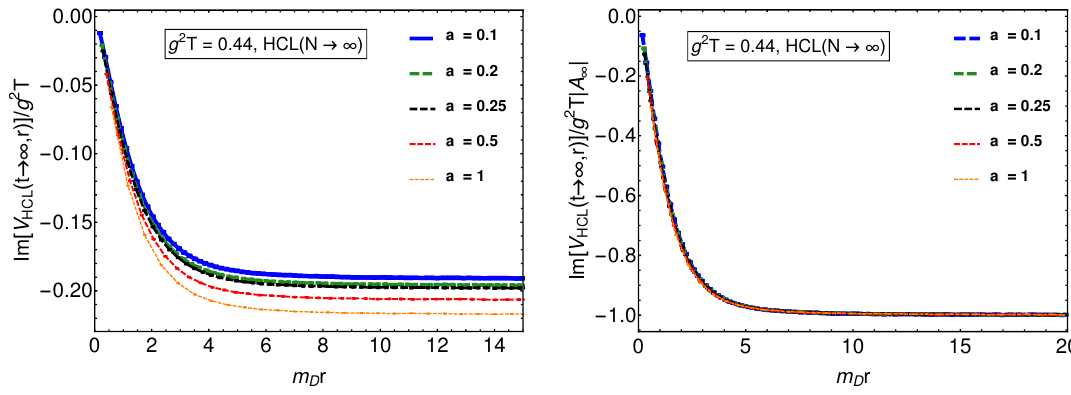
Figure 3 . (Left) Large-time limit of Im[ V (2) ( r )] /g 2 T for g 2 T = 0 . 44 and a ∈ { 1 , 0 . 5 , 0 . 25 , 0 . 2 , 0 . 1 } cl corresponding to β ∈ { 13 . 6 , 27 . 3 , 54 . 6 , 68 . 2 , 136 . 4 } , calculated using the infinite-volume hard clas- sical loop (HCL) approximation in (3.3). These numerical results are represented by points while fits using the function (3.5) are shown as lines. (Right) Same as in the left panel, but divided by the asymptotic value A ∞ ≡ lim r →∞ Im[ V (2) ( r )] /g 2 T . cl